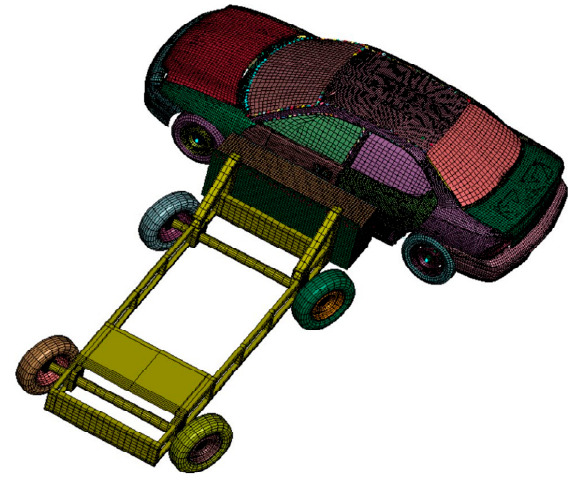
Figure 14. Schematic diagram of car crashworthiness design.